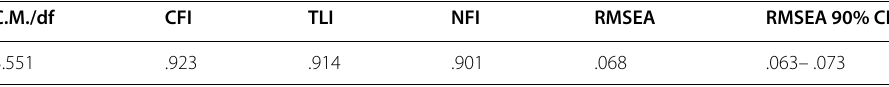
Table 2 Indicators of goodness of fit